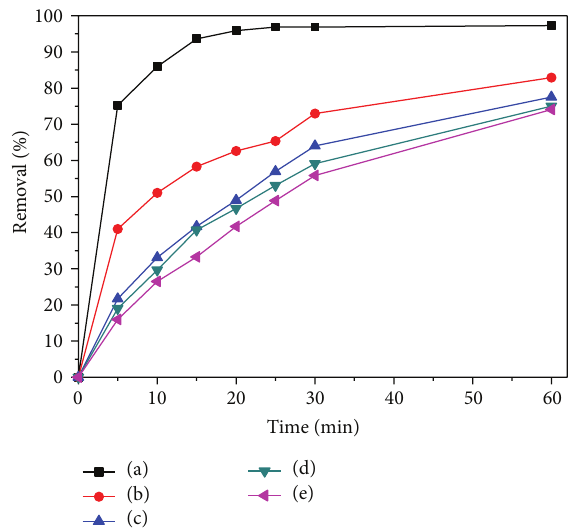
Figure 3: Temporal change in the concentration of nitrogen during the photodegradation. (a) Nitrate, (b) ammonia nitrogen, and (c) nitrite.